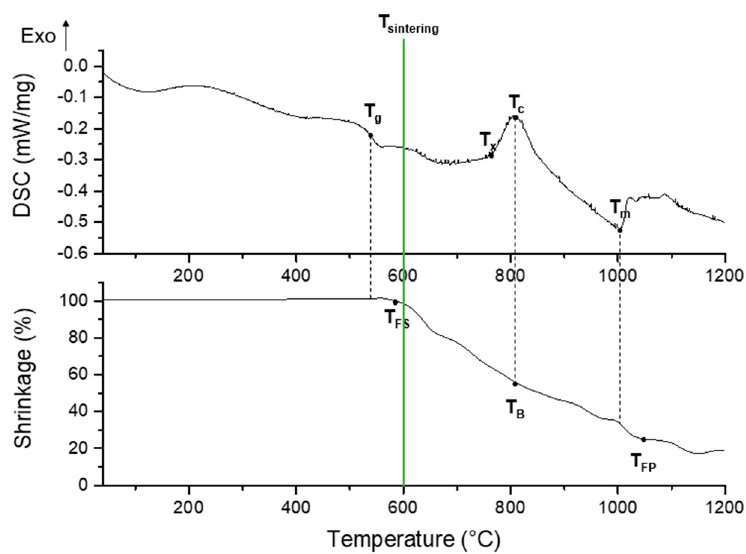
Figure 1. Differential scanning calorimetry (DSC) (top) and hot-stage microscopy (HSM) (bottom) plots illustrating the thermal characterization of 47.5B glass powders. Characteristic temperatures of the glass, as well as the sintering temperature chosen for scaffold fabrication, are highlighted on the plots.